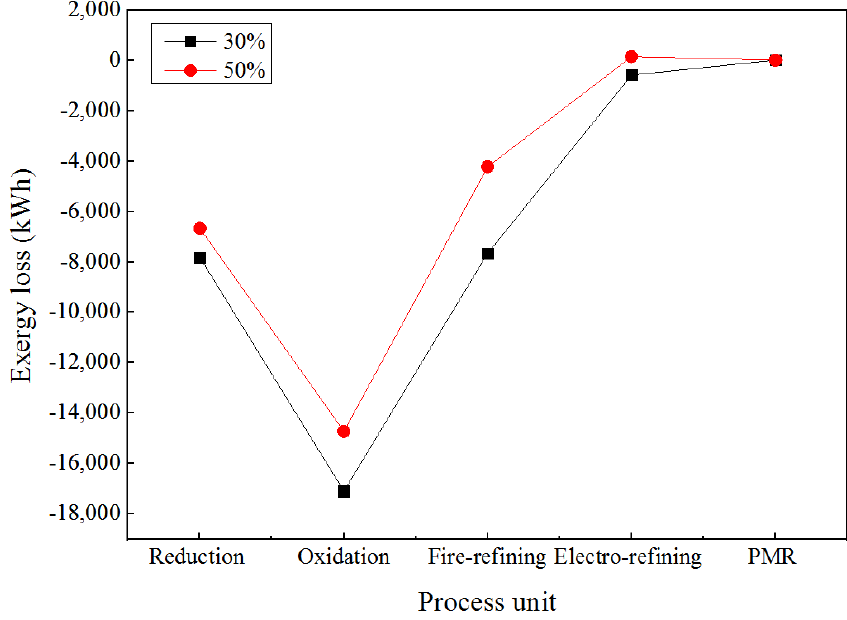
Figure 9. Exergy losses for different percentages of e-waste in the feed material.